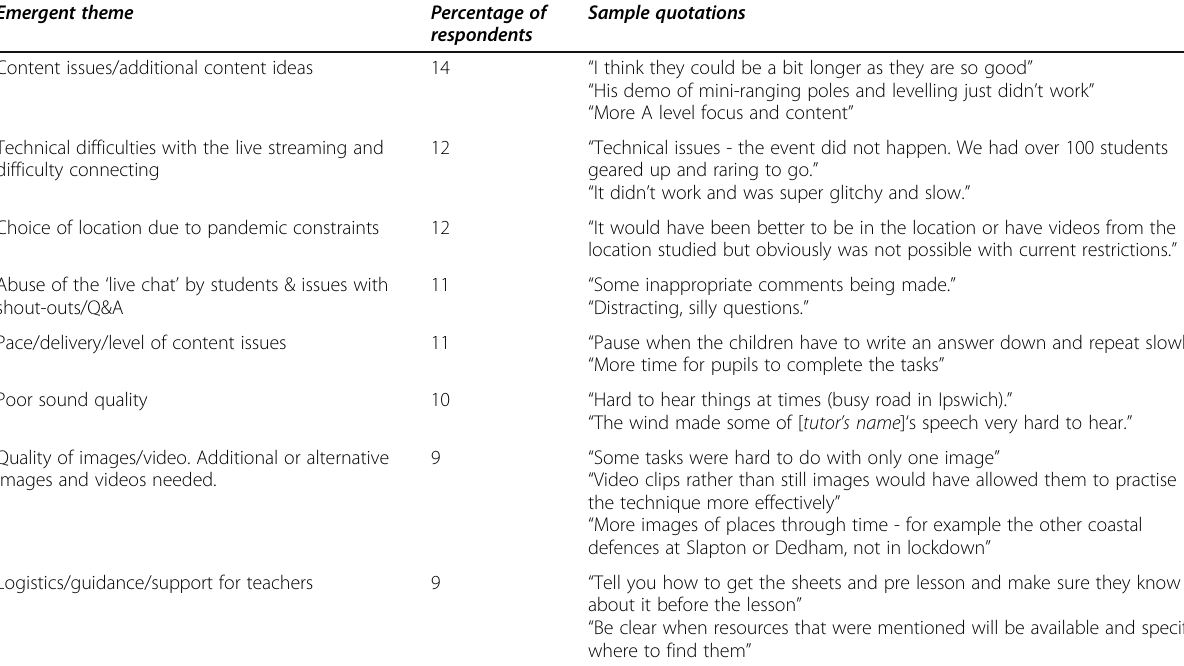
Table 3 Emergent themes in the content analysis for response data to the question: “ How could the #FieldworkLive sessions be improved? ” ( n = 145). Only themes with > 5% respondents are shown